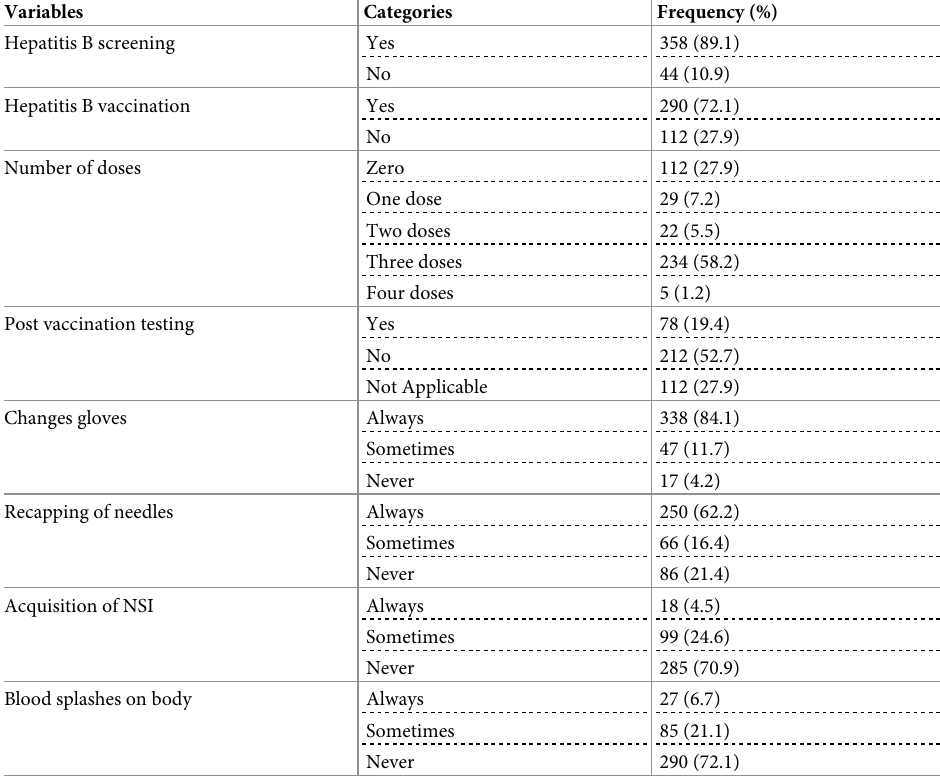
Table 4. Practice of hepatitis B infection prevention (n =